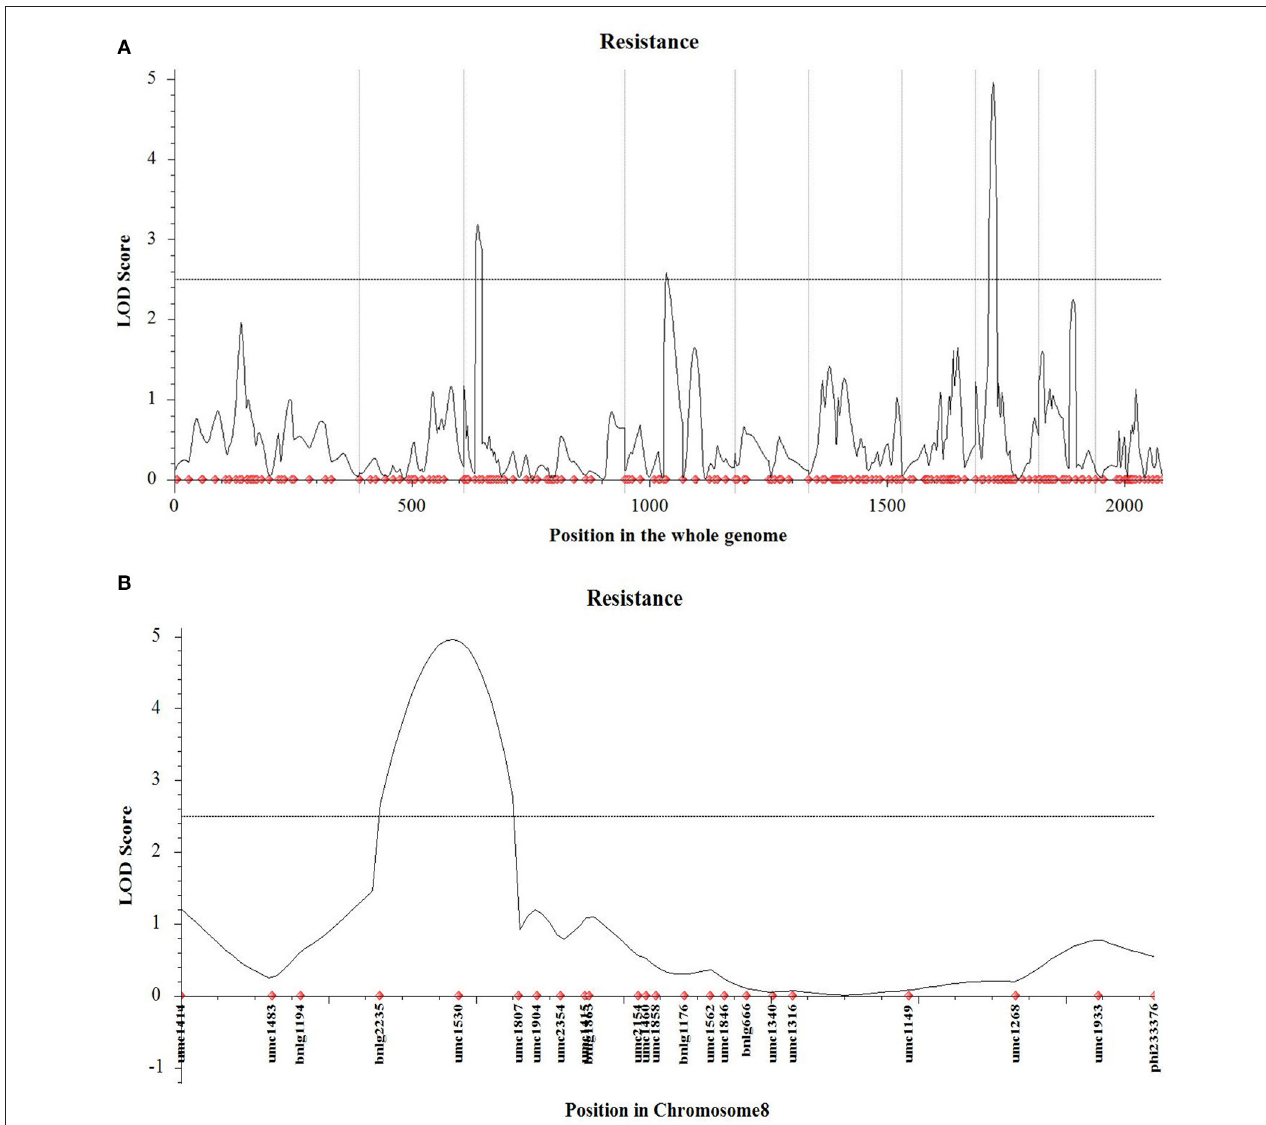
FIGURE 6 | (A) The resistant QTLs for maize stalk rot. (B) The QTL loci on chromosome